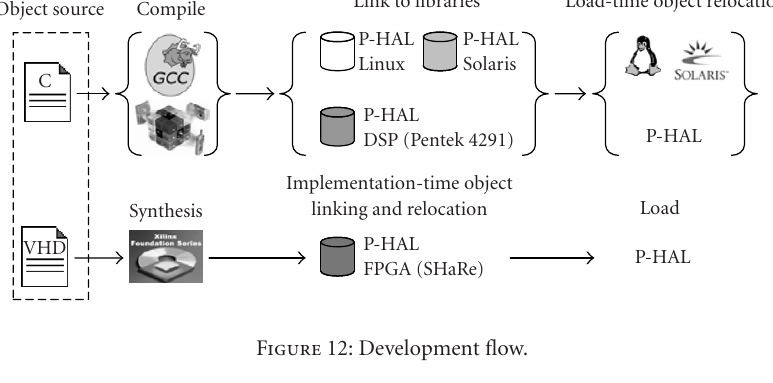
Figure 12: Development flow.